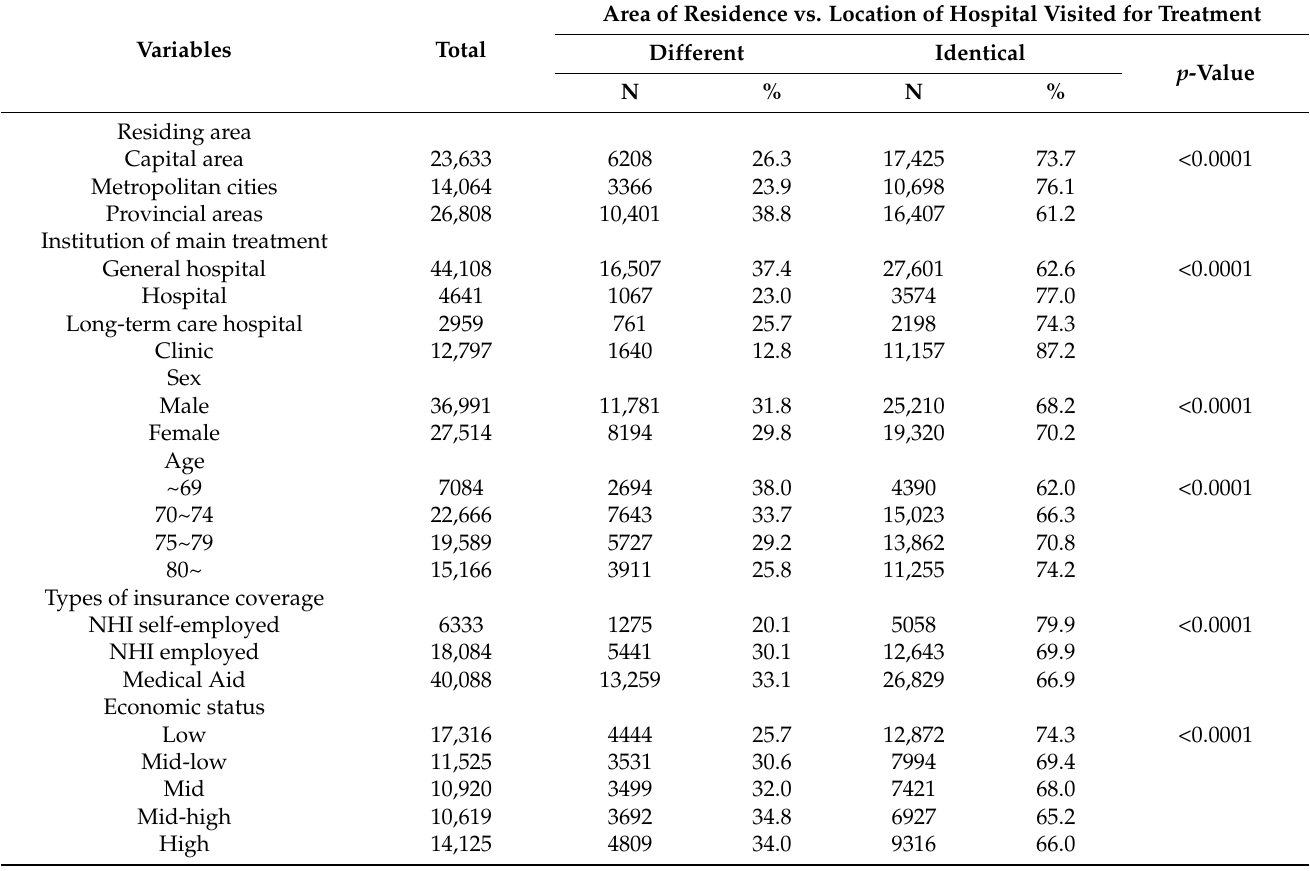
Table 1. General characteristics of the study